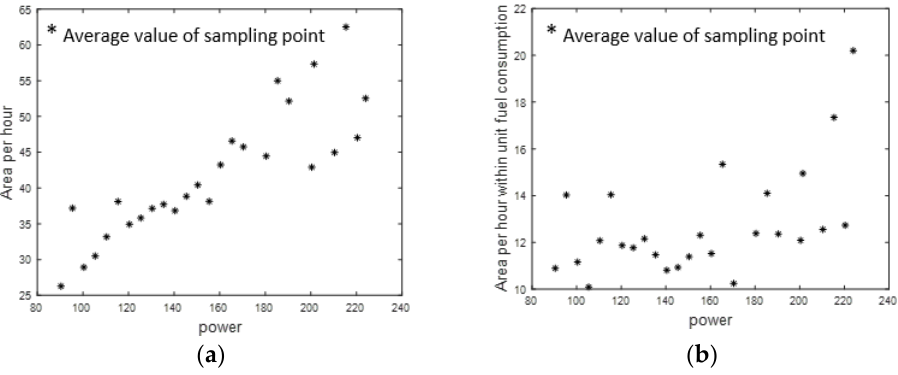
Figure 1. Operation effect picture of tractors with different horsepower. ( a ) Relationship between power and working area; ( b ) Relationship between power, fuel consumption and working area.